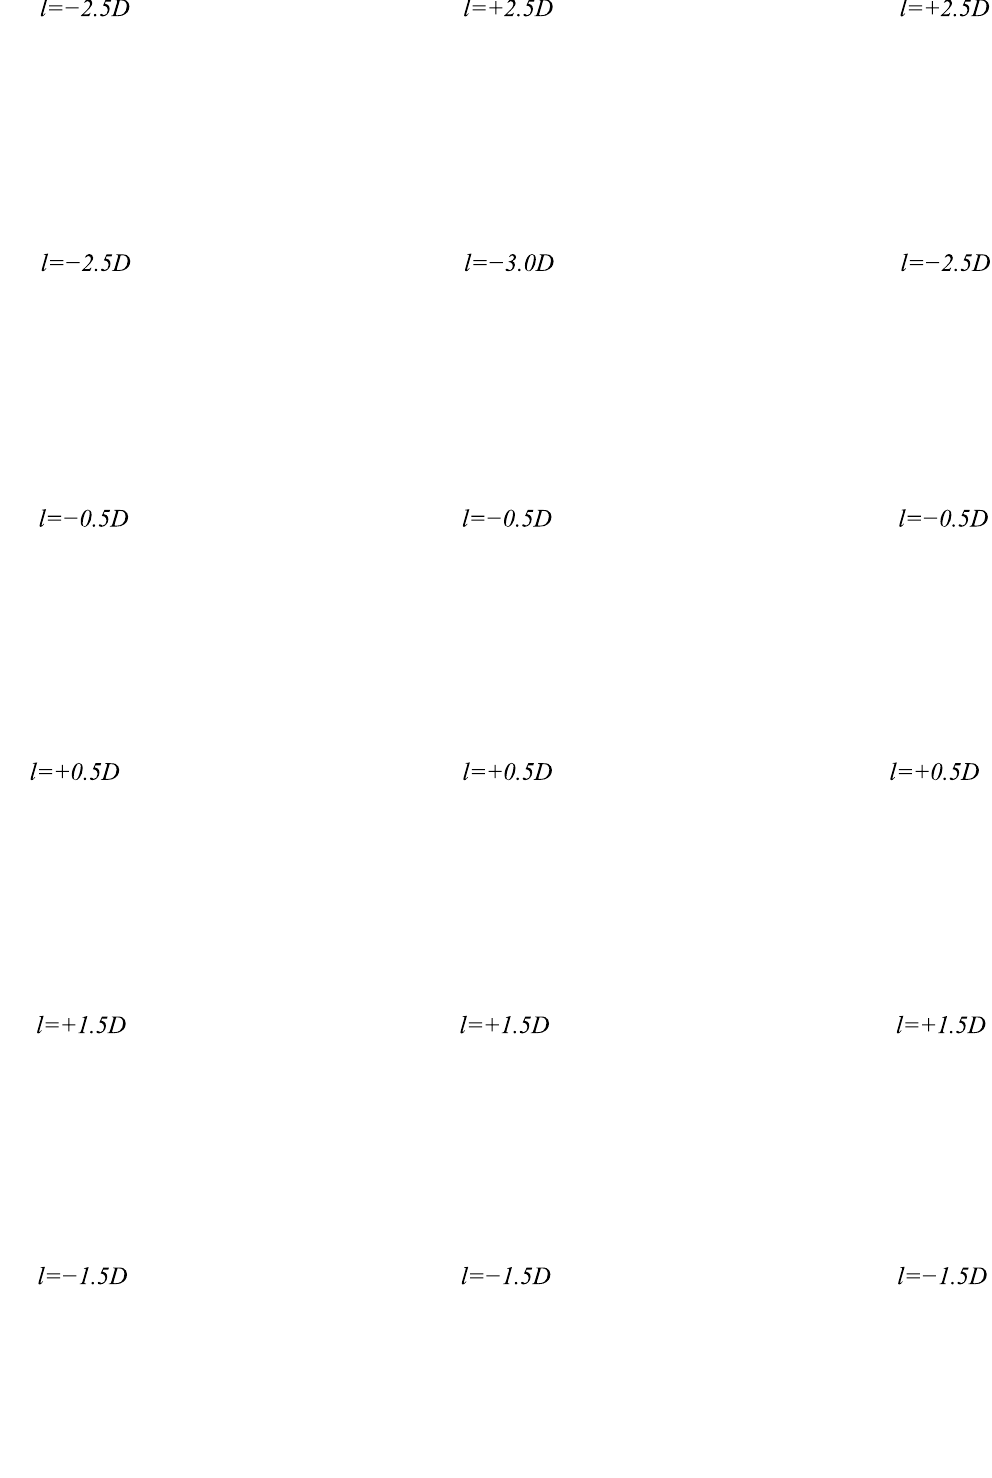
Figure 12. The velocity field on the wake side of the cylinders